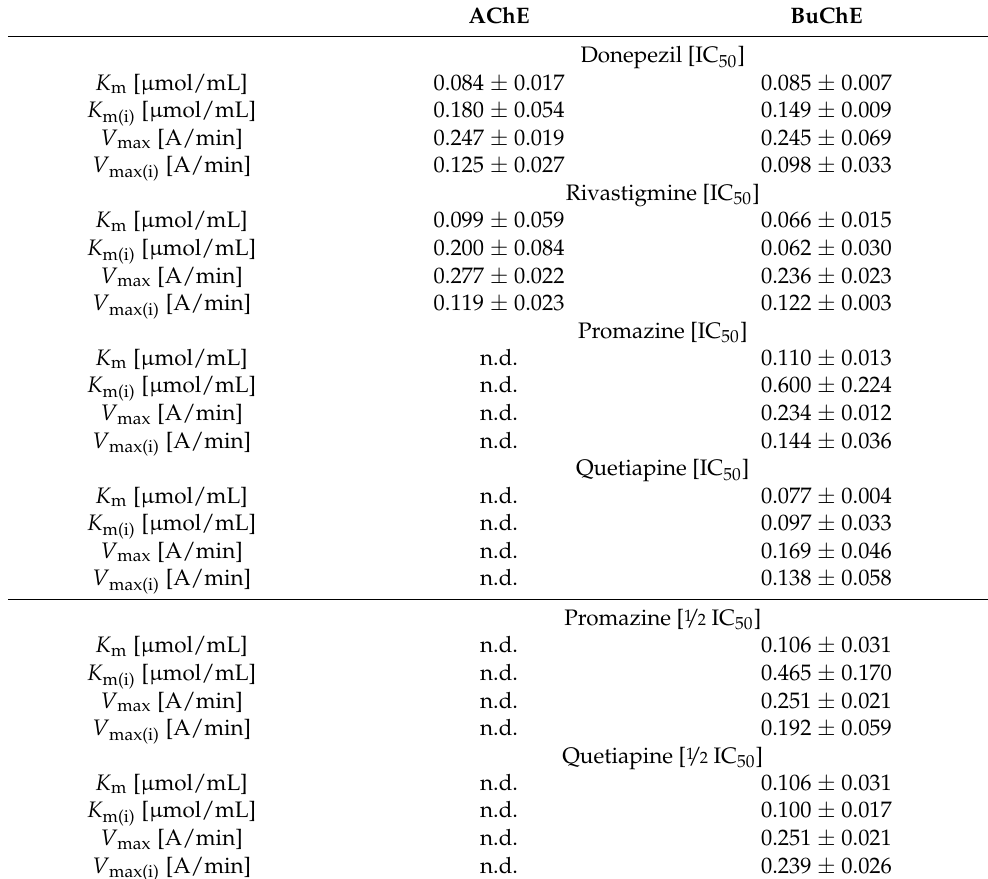
Table 2. Kinetic parameters of enzymatic reactions: K m , V max —kinetic parameters for pure enzyme; K m(i) , V max(i)— kinetic parameters of tested compounds (donepezil, rivastigmine at concentrations equal to their IC 50 values, and promazine, quetiapine at concentrations equal to their IC 50 and 1 / 2 IC 50 values).